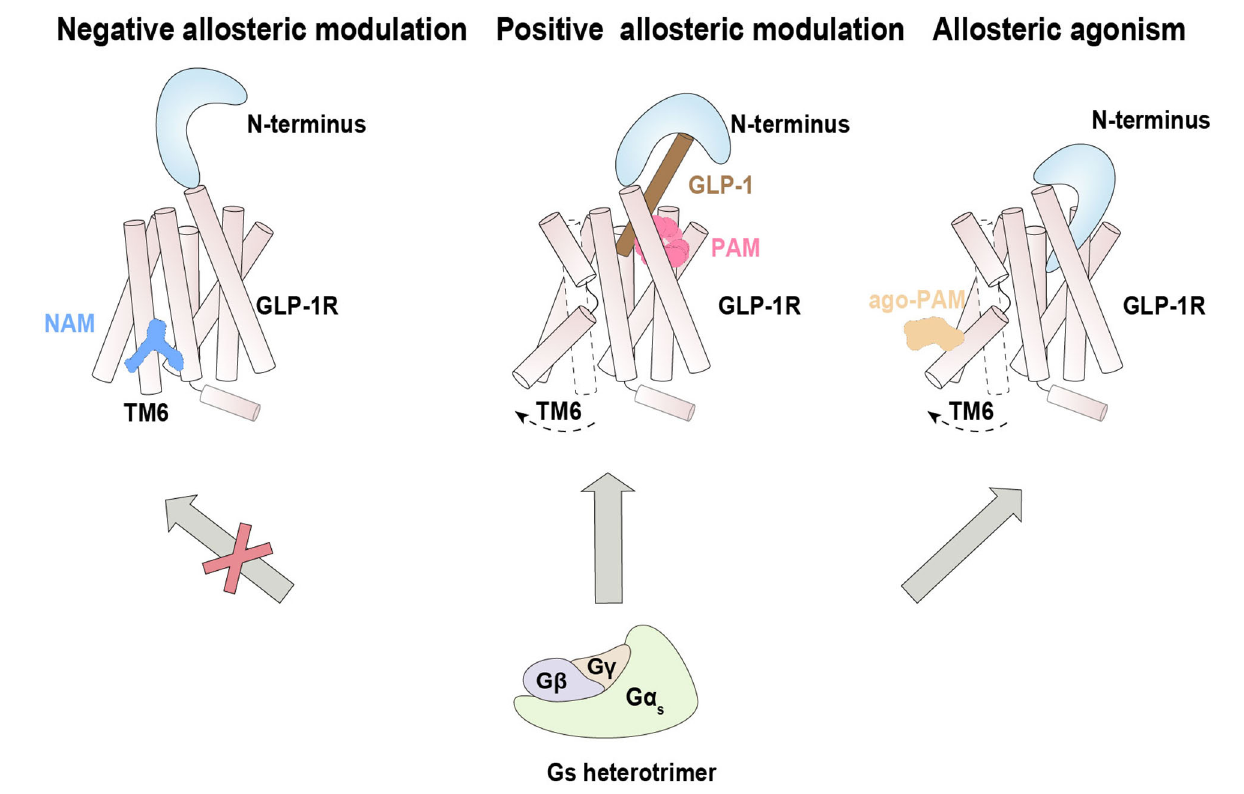
FIGURE 3 Allosteric modulation of GLP-1R signaling. Negative allosteric modulation of GLP-1R signaling (left), positive allosteric modulation of GLP-1R signaling (middle) and positive allosteric agonism of GLP-1R signaling